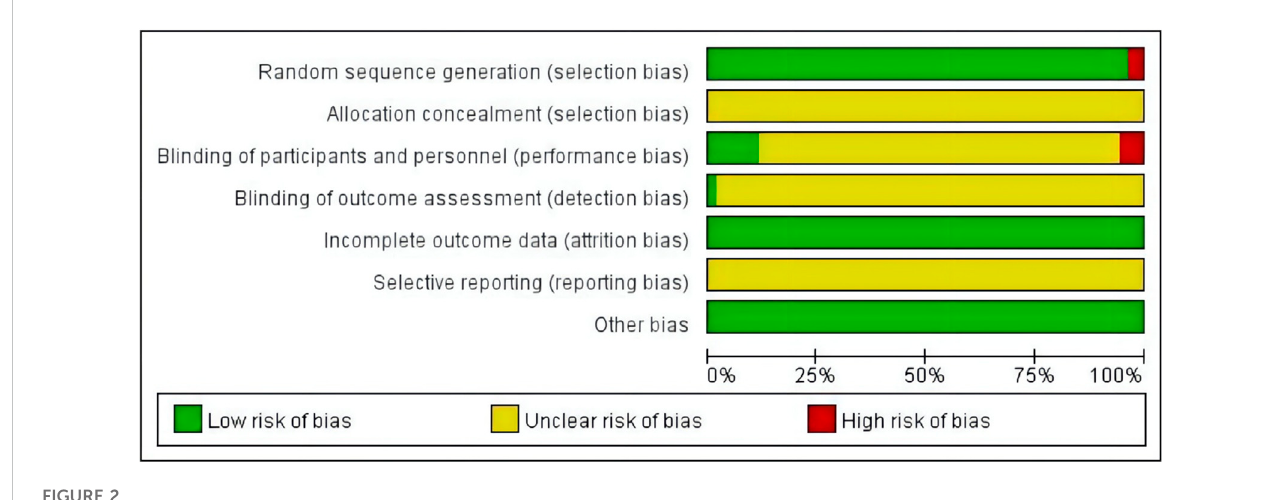
FIGURE 2 Summary of the risk of bias selection.